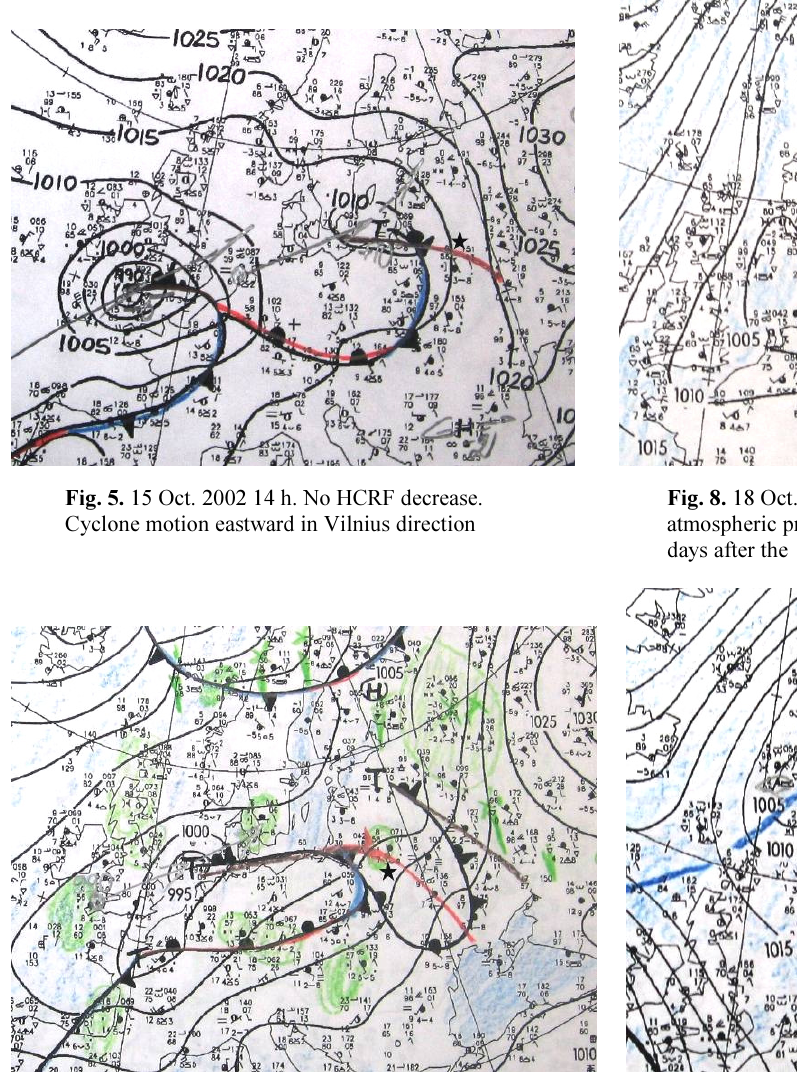
Fig. 6. 16 Oct. 2002 14 h. No HCRF decrease. Fig. 9. 20 Oct. 2002 14 h. Time interval 9–10 hours of Cyclone motion eastward in Vilnius direction HCRF registration and its decrease (–48